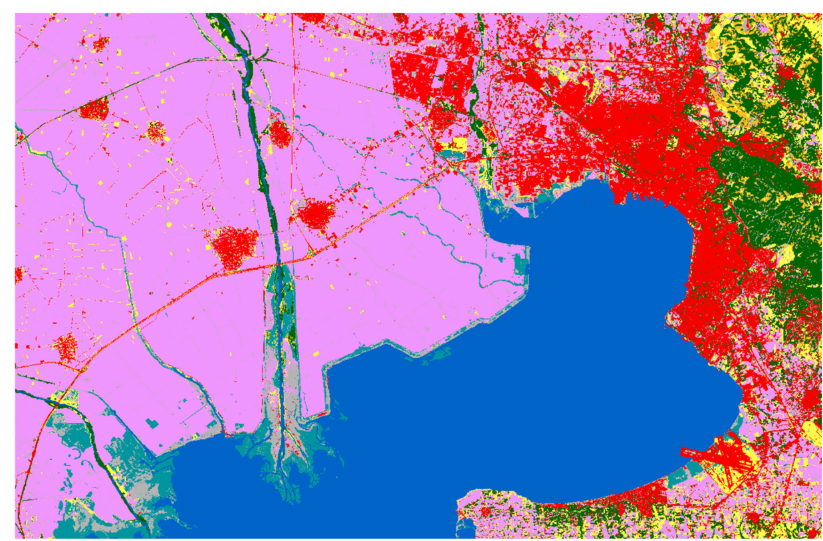
Figure 12. Ground Truth, WorldCover Layer using the colour coding of Table 1.